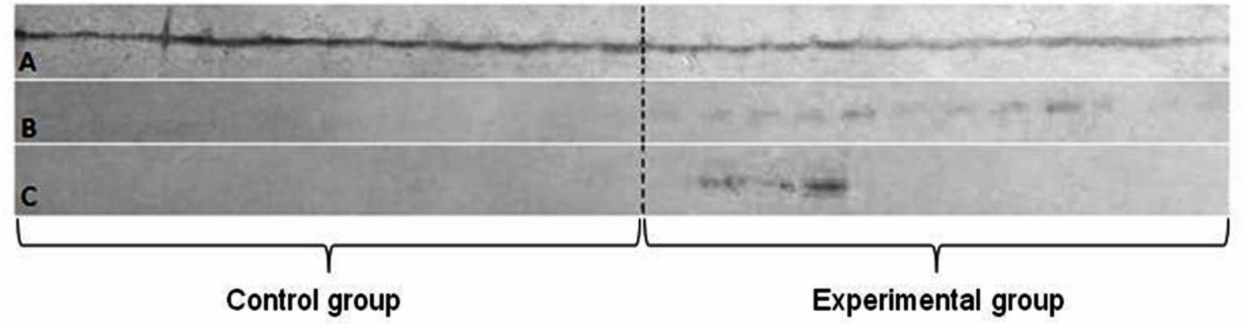
Figure 4. The simultaneous detection of metallothionein 1 and 2 in Western blot technique. Letters stand for: A—liver; B—lung;